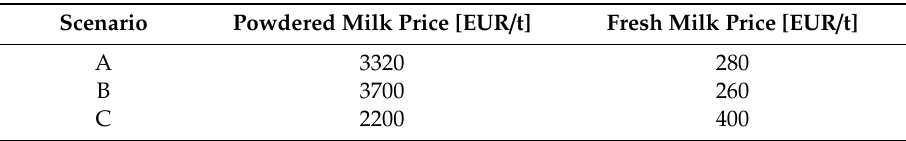
Table 7. Milk price inputs in economic analysis.